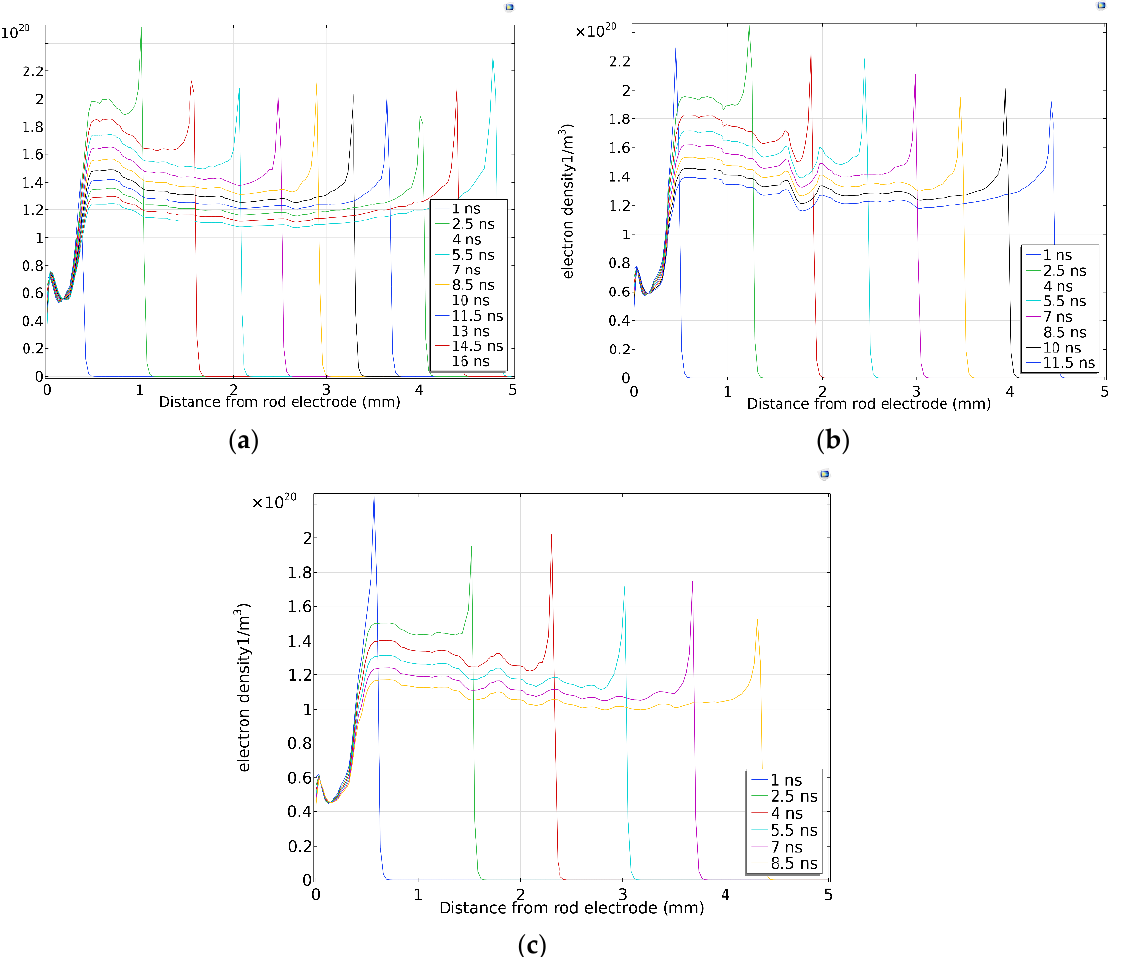
Figure 5. One-dimensional distribution of electron concentration along the axis: ( a ) 101 kPa, ( b ) 85 kPa, ( c ) 70 kPa.